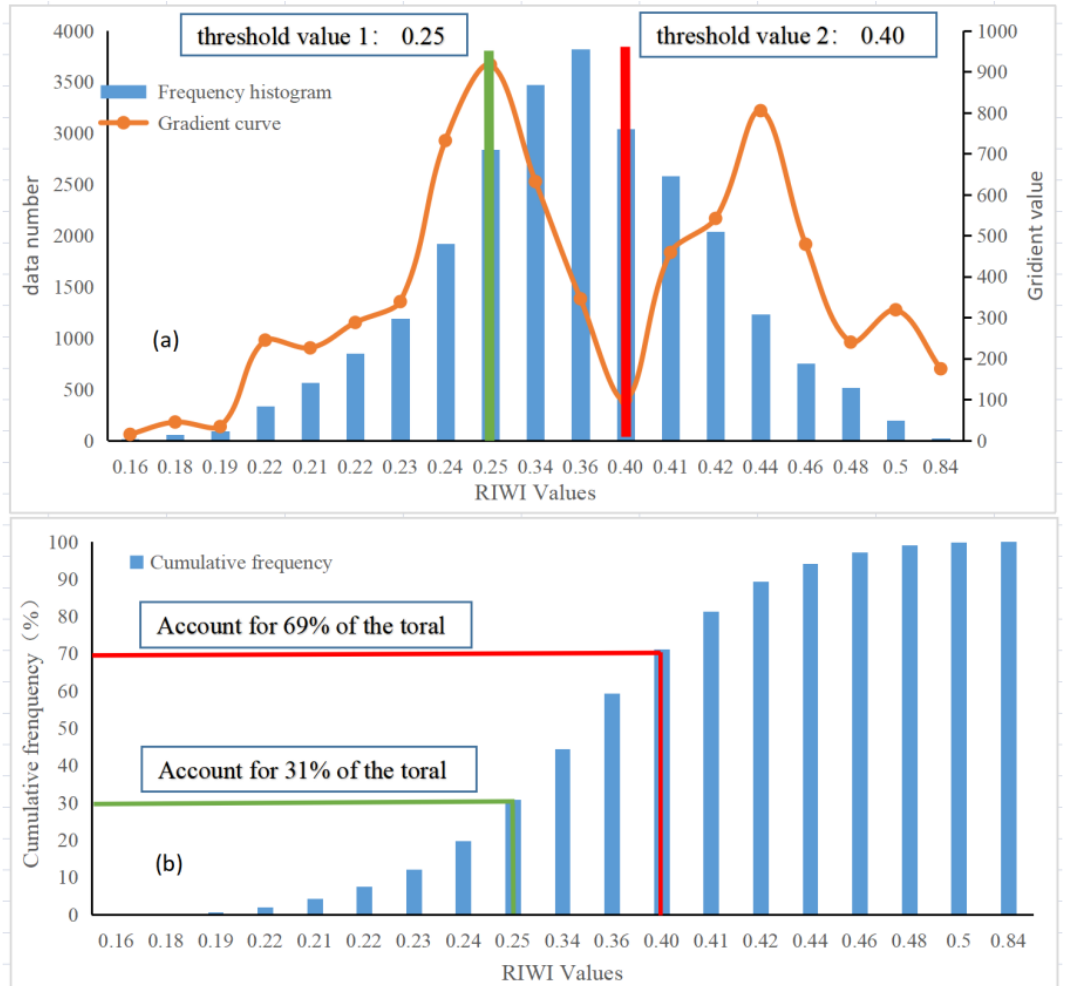
Figure 7. Statistics of the RIWI values. (a) frequency histogram and natural break points distribution (b) cumulative frequency histogram